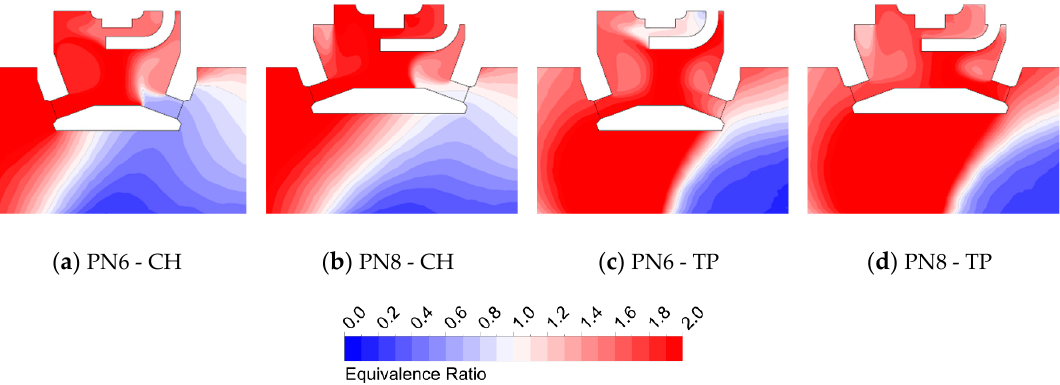
Figure 21. Equivalence ratio contours inside the prechamber at TDC for the 7500 rpm and 30% of load case: comparison between the two prechamber geometries for both injection strategies.